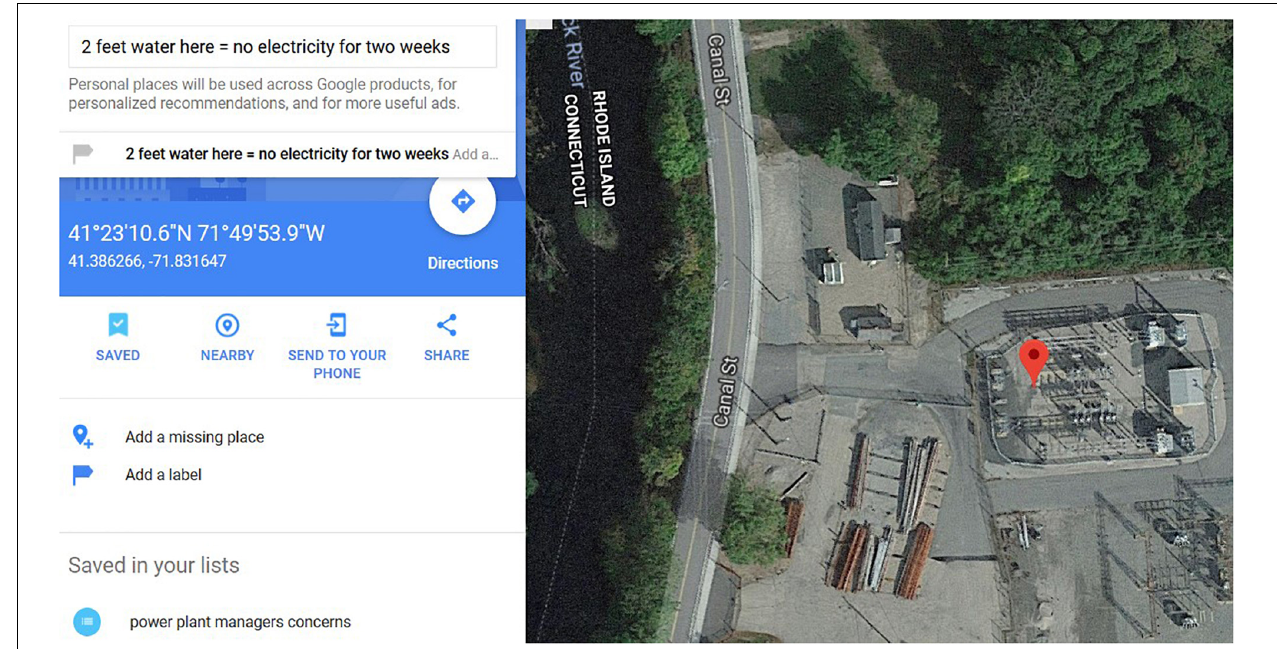
FIGURE 4 | Interviewee ’s used Google maps satellite views to identify and label locations of concern (Image: authors, data Google Maps).